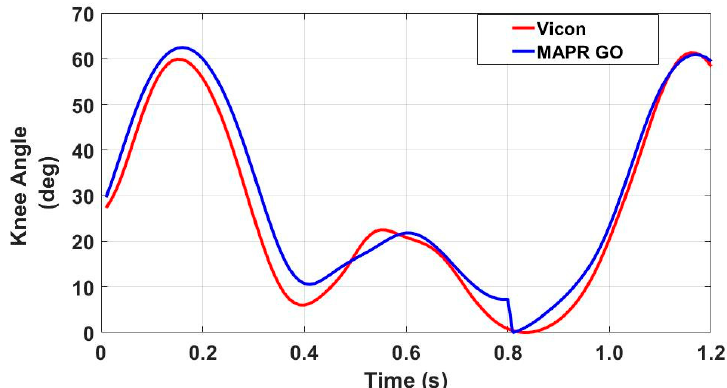
Figure 10. Representative knee angle waveform extracted from a single pass using a motion capture system and IMU-based gyroscope only algorithm. Similar waveforms were observed between the two signals, with comparable peak heights and the largest difference in the signal set in a trough in between peaks.